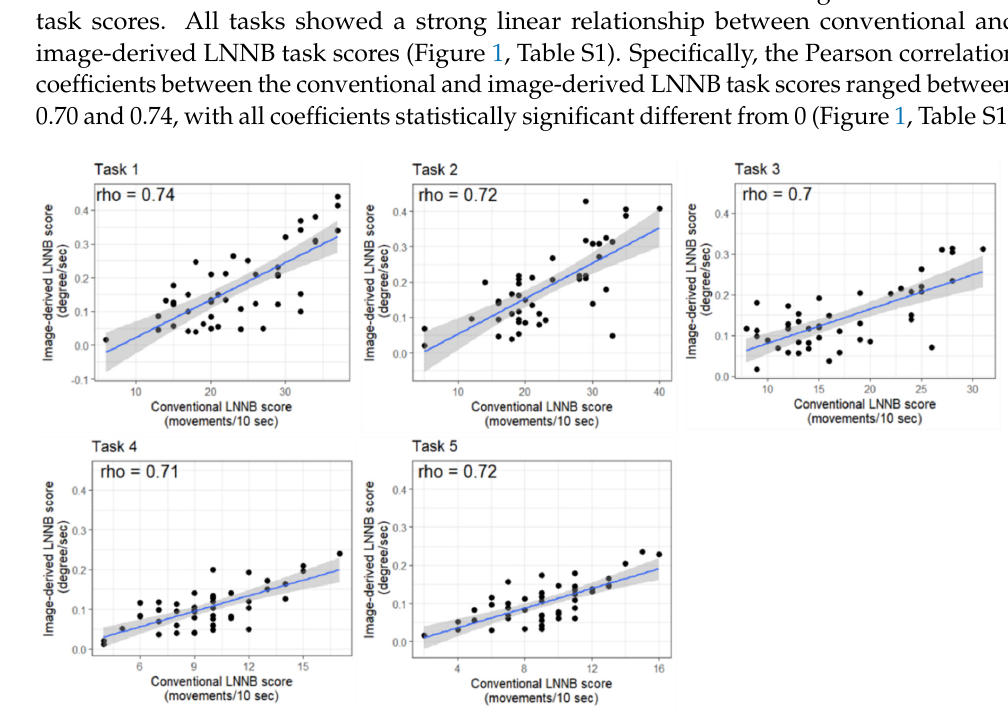
Figure 2. Receiver Operating Characteristic (ROC) curve (solid black line), empirical 95% confidence interval (grey shade), and area under the ROC curve (AUC) of the image-derived Luria-Nebraska Neuropsychological Battery (LNNB) tasks, classifying participants with lower mobility (LNNB score < population mean levels). Dashed grey line indicates the line of no-discrimination. Task 1: the dominant hand clench, Task2: the finger–thumb touching with the dominant hand, Task 3: the non-dominant hand clench, Task 4: the finger–thumb touching with non-dominant hand, Task 5 alternative hand clench.